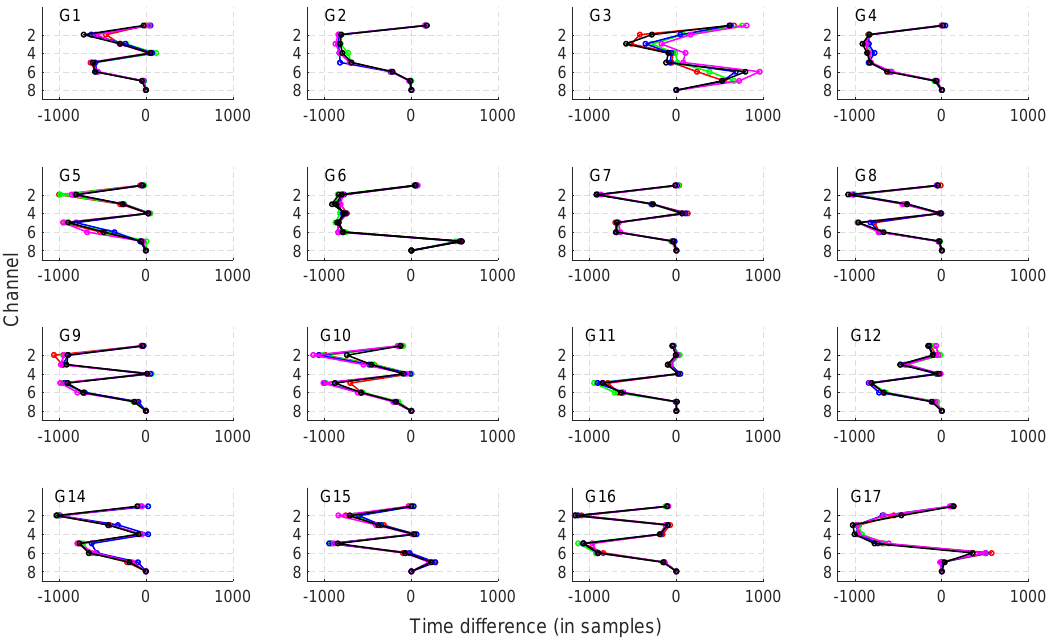
Figure 7. Activation profiles of eight muscles during golf swing for 16 different golf players. Note: channel 8 (left trapezius ) was used as the reference for measuring time differences for remaining